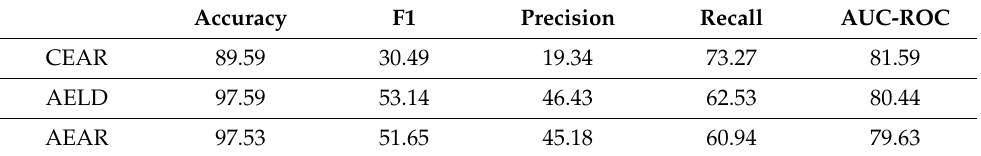
Table 1. Average Performance Metrics of Eye Blink Detection